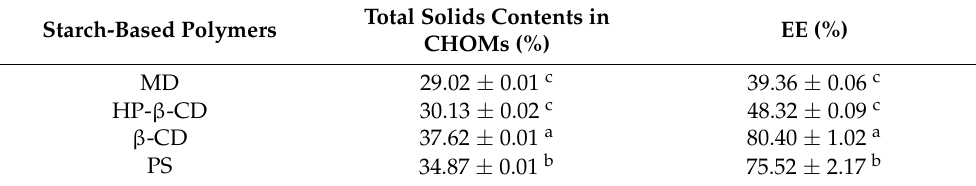
Table 1. Encapsulation efficiency of different starch-based wall materials to CHO. Starch-Based